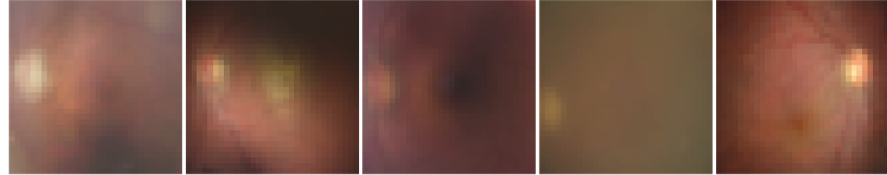
Figure 9. Fundus images compressed into 32 × 32 × 3 for SVM (RBF kernel).